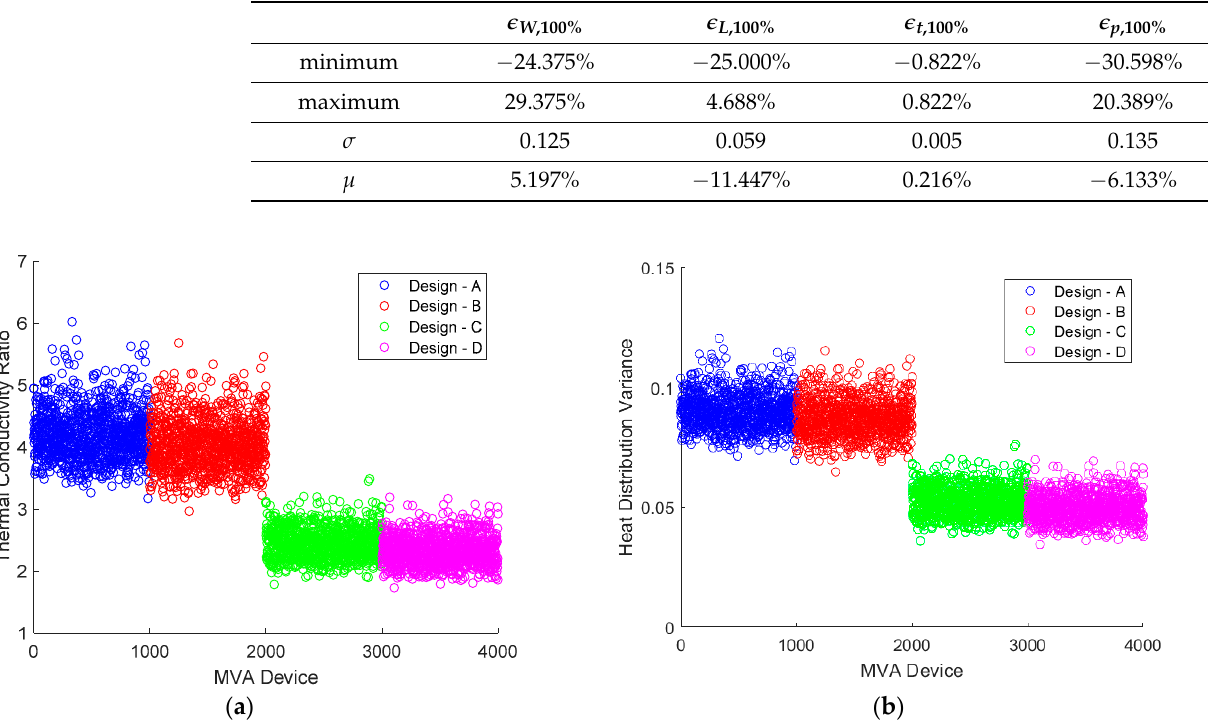
Figure 7. ( a ) Error-compensated theoretical thermal conductivity ratio for PCB-based MVAs; ( b ) variance of the heat spreading profile using error-compensated theoretical thermal conductivity ratio for PCB-based MVAs.